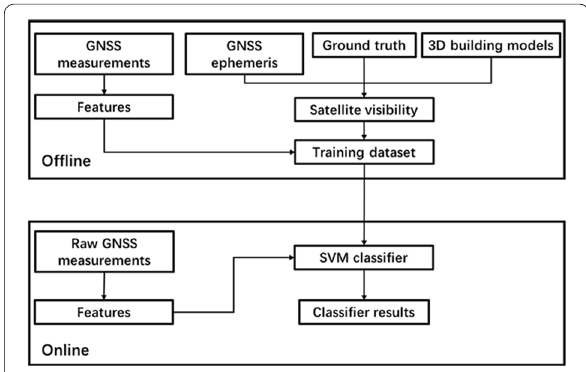
Fig. 3 Flowchart of the proposed LOS/NLOS SVM classifier